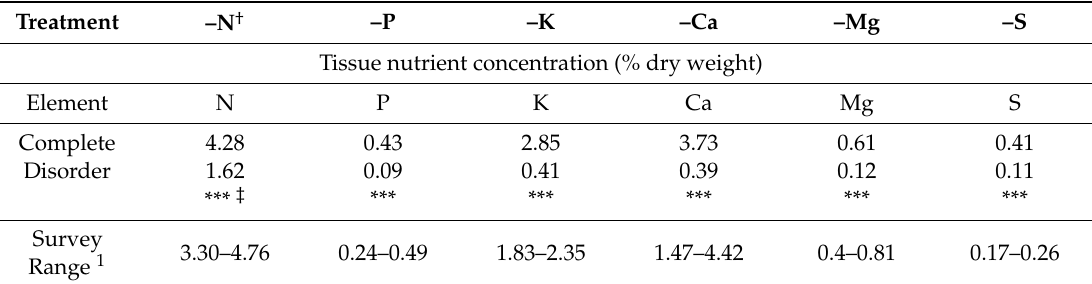
Table 2. Foliar nutrient concentrations of Cannabis sativa ‘T1’ grown with a deficient macronutrient compared to plants grown with a complete fertilizer